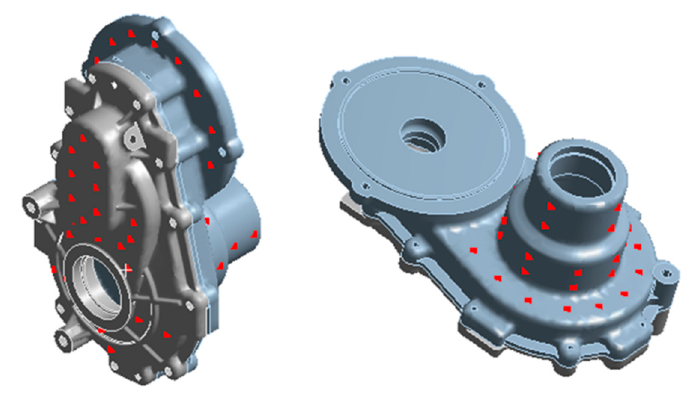
Figure 8. Points evaluated for local stiffness.